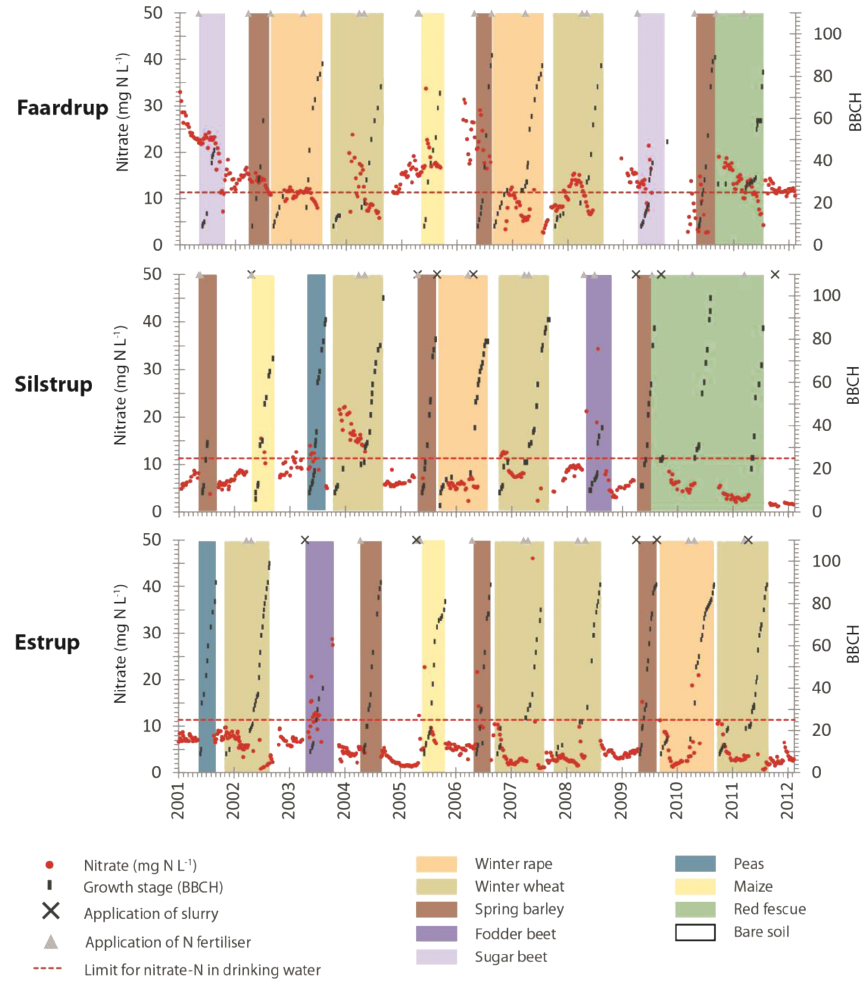
Figure 4. Crop type, specific growth stage of crops according to the BBCH scale, application of inorganic N fertiliser and injection of slurry and concentration of nitrate-N (mgNL − 1 ) in drainage at Faardrup, Silstrup and